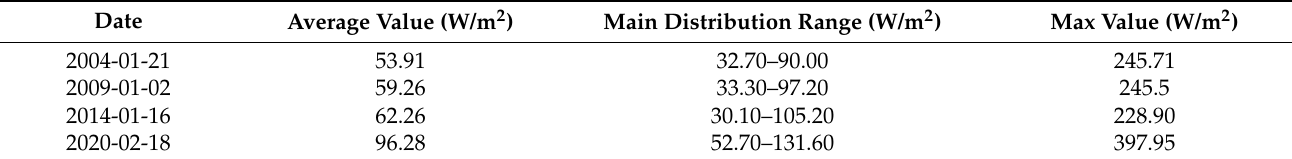
Table 4. Statistics of anthropogenic heat in the study area.